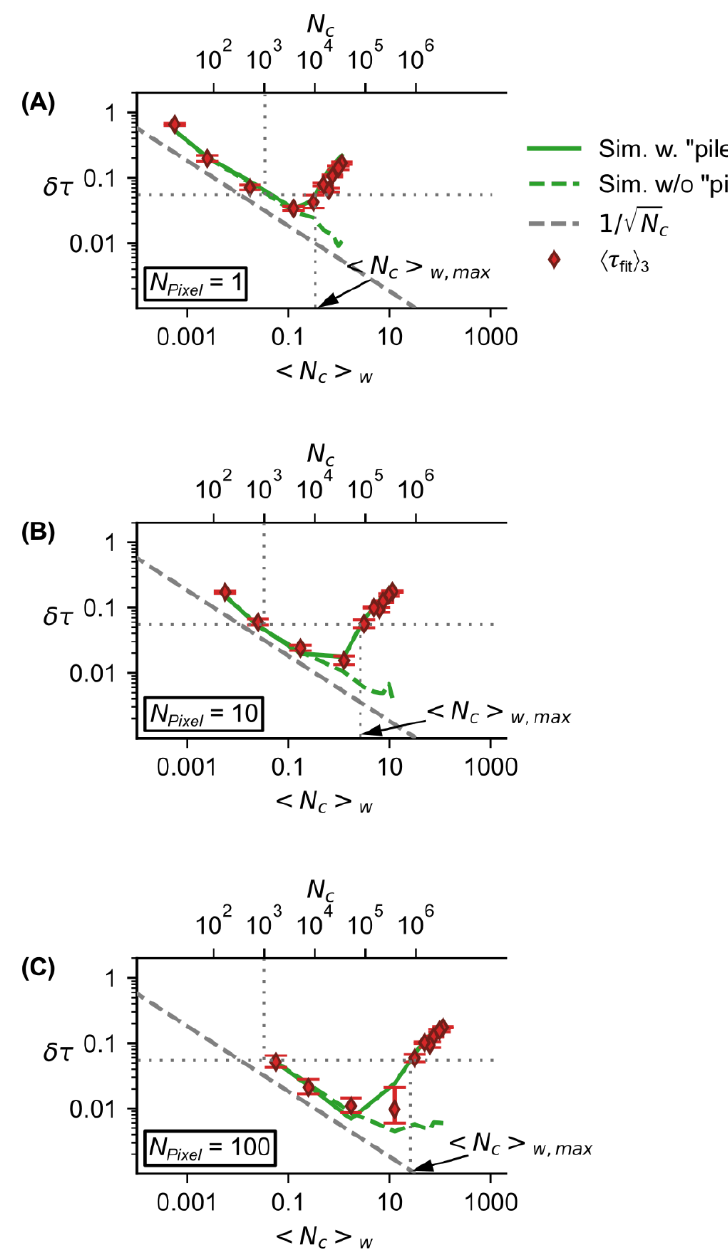
Figure 8. Impact of the detector’s pile-up on relative accuracy of determined FL. Relative accuracy δτ of the measured lifetime τ vs. count rate (cid:104) N c (cid:105) w for different number of the SPAD array detector’s active pixels ( A , 1 pixel; B , 10 pixels; C , 100 pixels). At a relative accuracy of δτ = 5.5% which corresponds to a photon counts of N c = 1000 the maximum count rate (cid:104) N c (cid:105) w,max is larger for higher number of pixels ( A – C ).